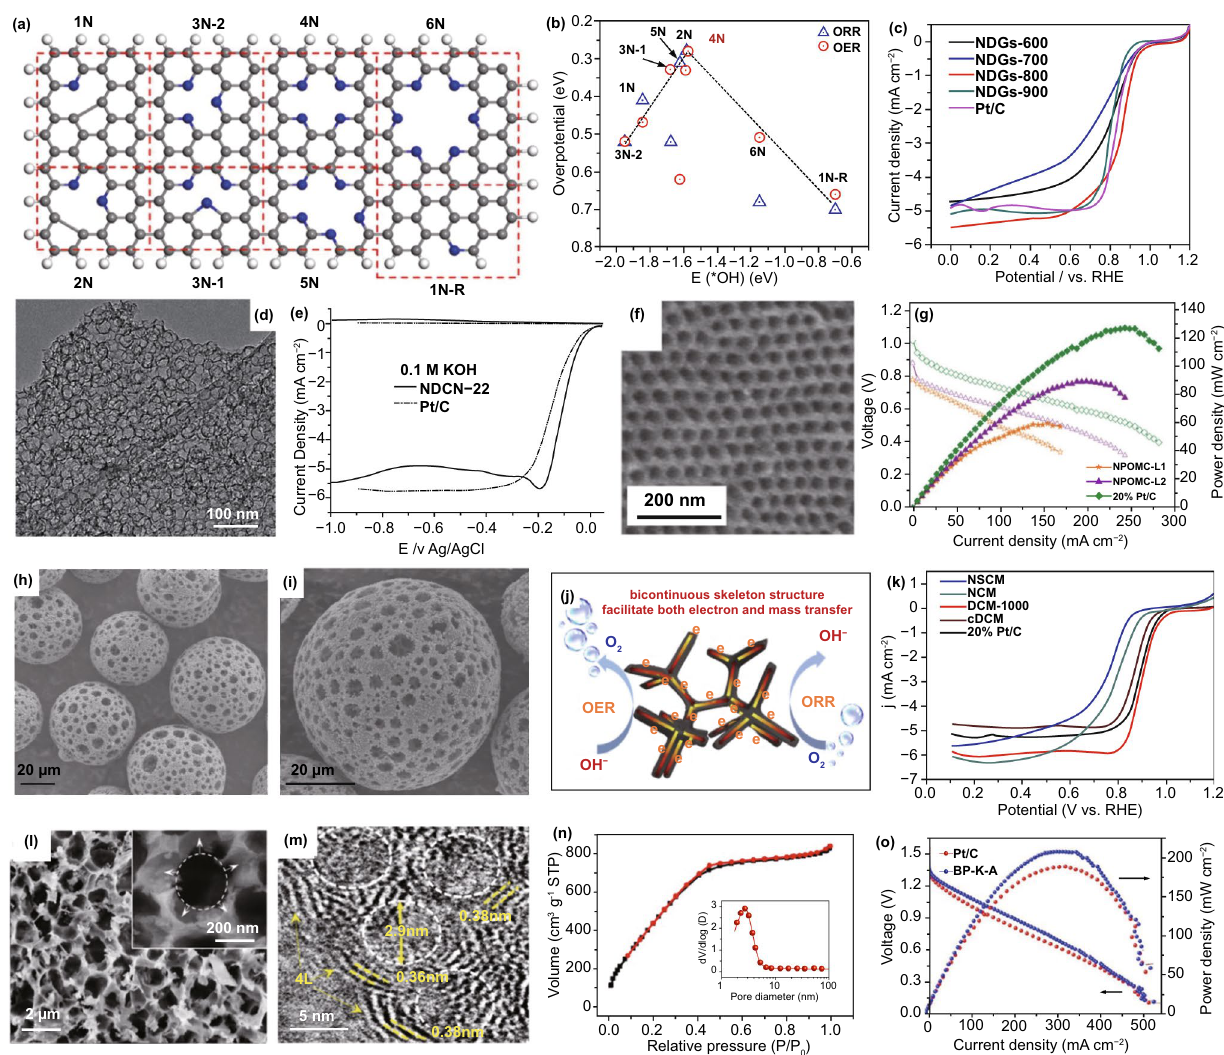
Fig. 6 Pore defects coupled with dopants in nanocarbon for ORR. a Synergetic active sites of vacancy defects and N dopants, and b the corre- sponding ORR and OER volcano plots; c ORR polarization curves of the samples and Pt/C catalyst. Reproduced with permission from Ref. [50]. Copyright 2018, American Chemical Society. d TEM image of NDCN-22; e RRDE measurement of NDCN-22 and Pt/C catalysts in alkaline media. Reproduced with permission from Ref. [106]. Copyright 2014, Wiley–VCH. f TEM image of NPOMC-L2 sample; g polarization curves of AEMFCs used NPOMC-L1, NPOMC-L2, and Pt/C catalysts. Reproduced with permission from Ref. [107]. Copyright 2015, Wiley–VCH. h , i SEM images of DCM-1000; j schematic representation of DCM-1000 for ORR and OER; k LSV curves of the samples and Pt/C catalyst. Reproduced with permission from Ref. [109]. Copyright 2019, Elsevier. l SEM and m TEM images of BP–K–A; n N 2 adsorption–desorption isotherm and pore size distribution of BP–K–A; o Polarization curves and power density plots of Zn–air batteries fabricated with BP–K–A and Pt/C electrodes. Reproduced with permission from Ref. [110]. Copyright 2017,